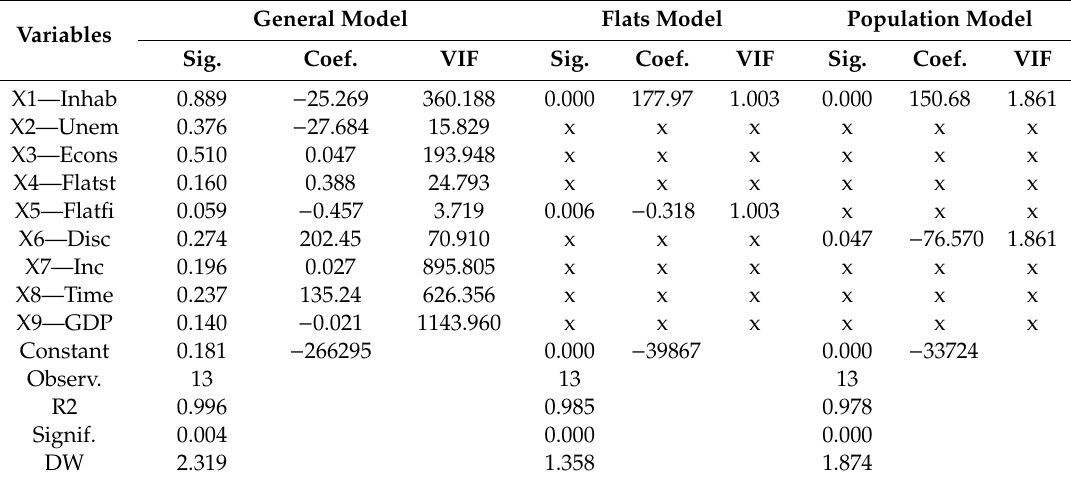
Table 5. Regression analysis for